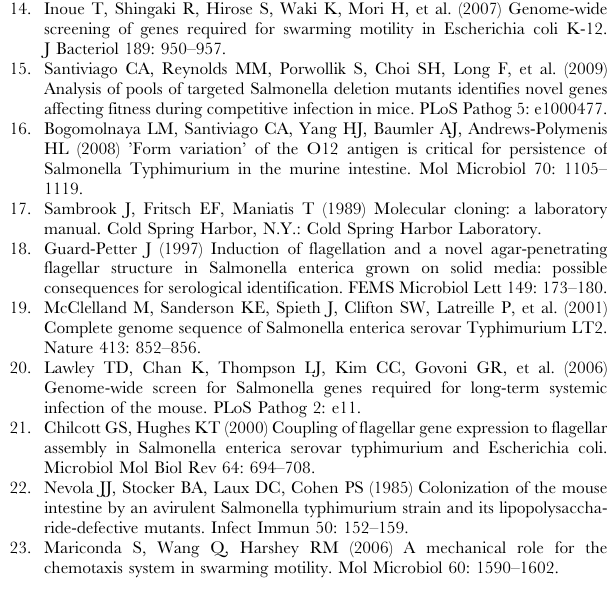
Table S1 Swimming and swarming motility scores from high-throughput screening. Table S2 Confirmation of motility defects (loss of . 75% motility compared to wild type) in mutants identified in primary screening. Table S3 Mutants with defect in swimming motility only. Table S4 Mutants with defect in swarming motility. Table S5 Previously described hypermotility in bacte- ria. Table S6 Densitometry data underlying Figures 3 and 5, and representative images of Western blots used to generate this